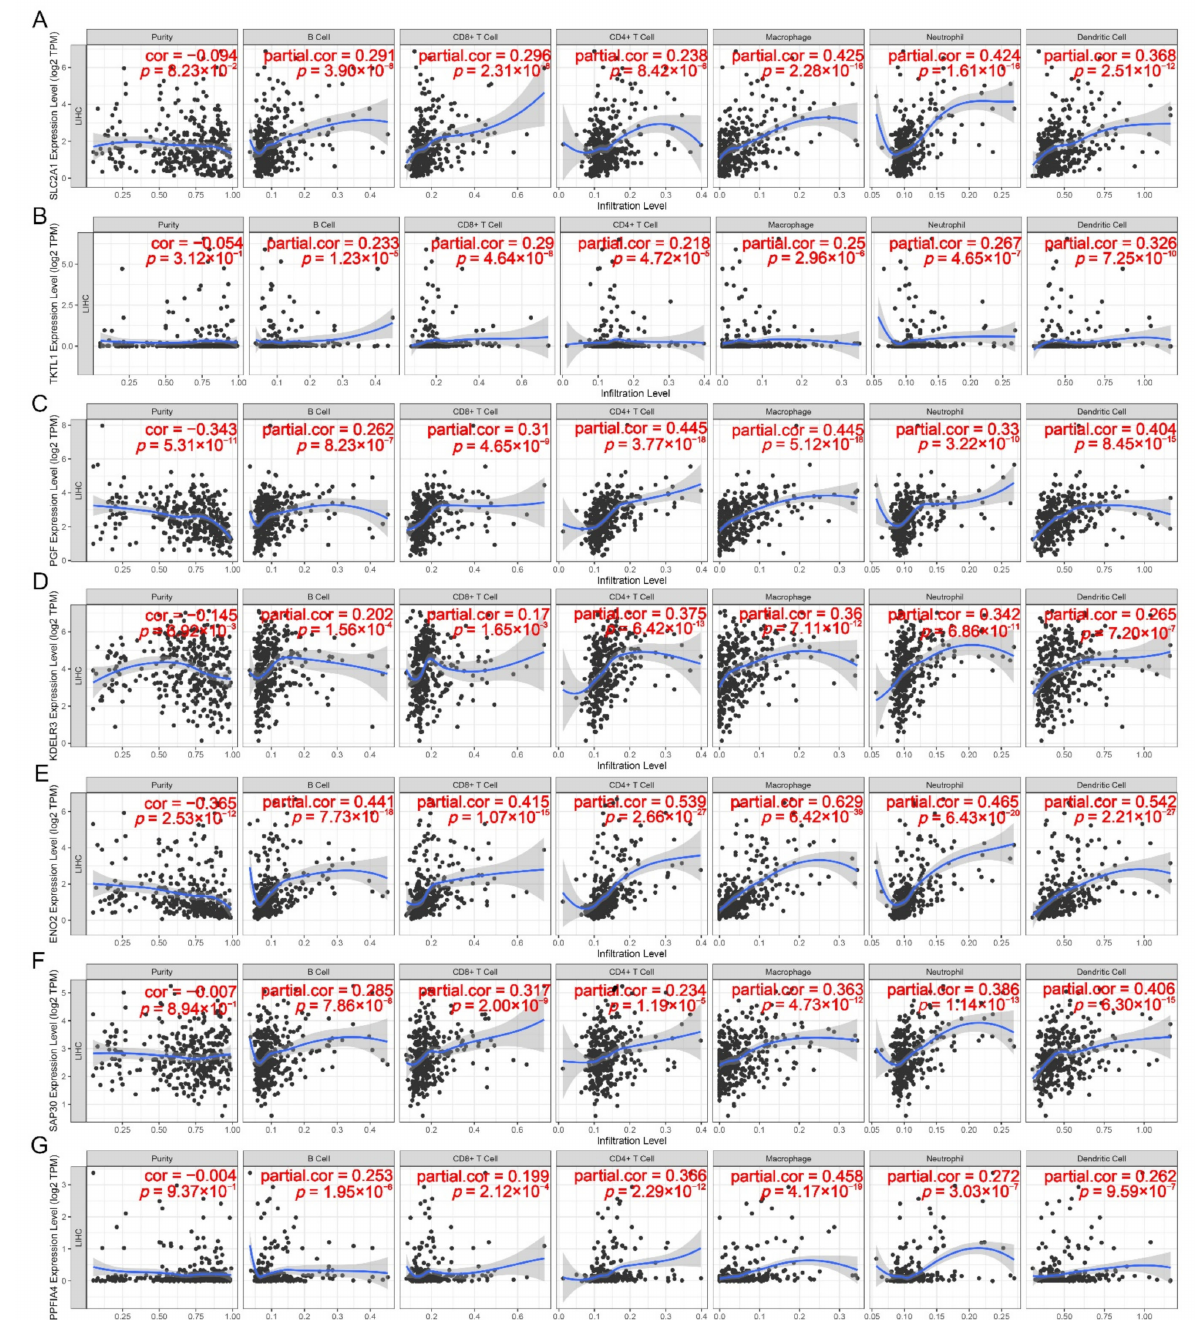
Figure 5. Correlation between the expressions of seven HR-DEmRNA-os and six tumor immune cells in hepatocellular carcinoma ( p < 0.05 was considered to be significantly correlated). ( A ). SLC2A1, ( B ). TKTL1, ( C ). PGF, ( D ). KDELR3, ( E ). ENO2, ( F ). SAP30, ( G ).